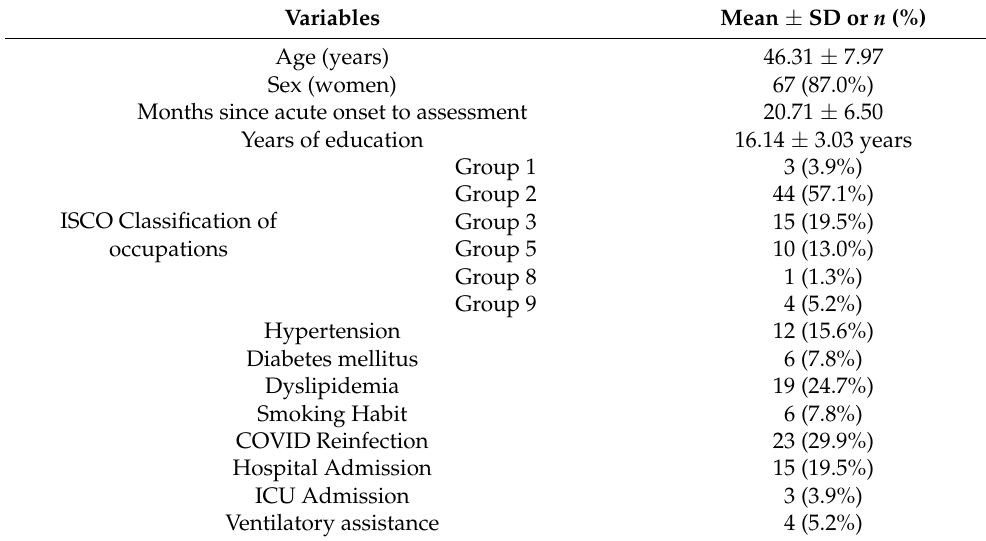
Table 1. Main demographic and clinical